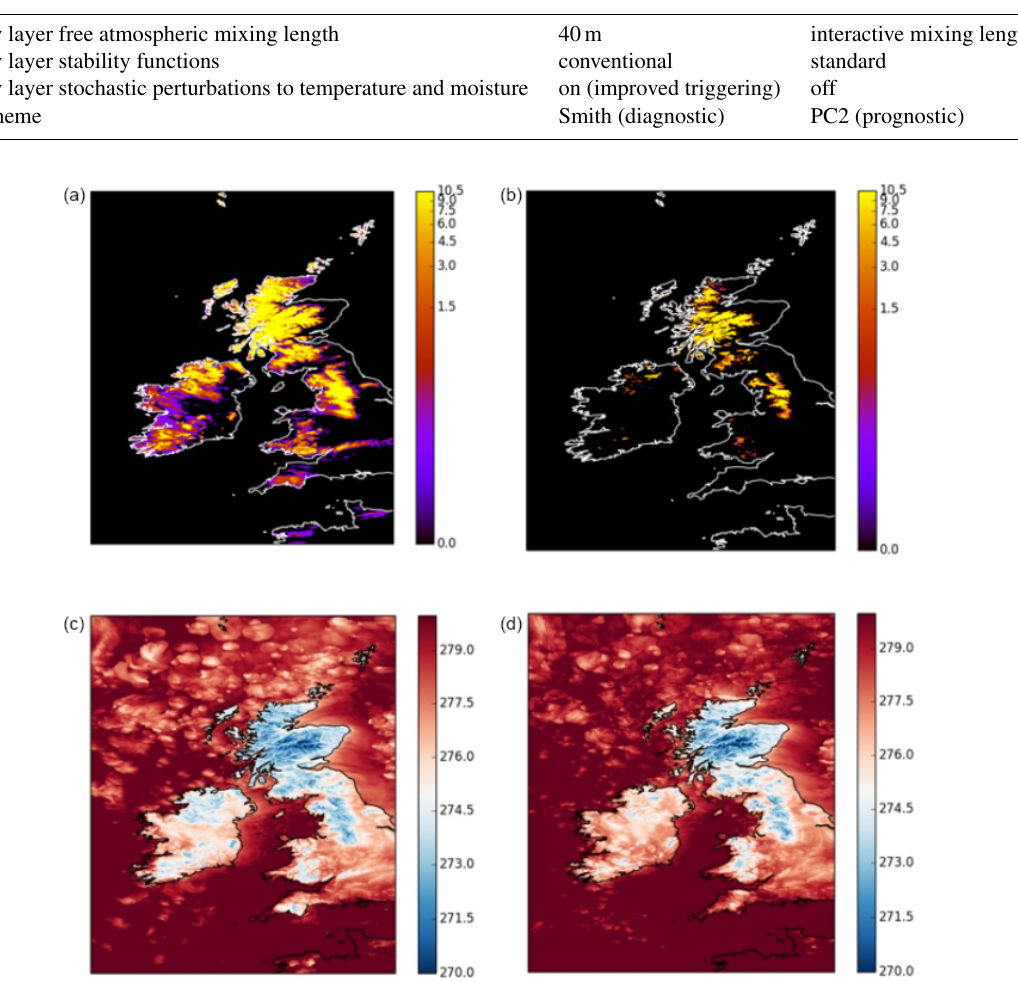
Figure 3. 18 November 2016 12Z. UKV case study at T+60 showing snow amount (kgm − 2 ) (a, b) and screen temperature (c, d) for RAL1-M (a, c) and RAL1-M with improvements to the treatment of lying snow (b, d)